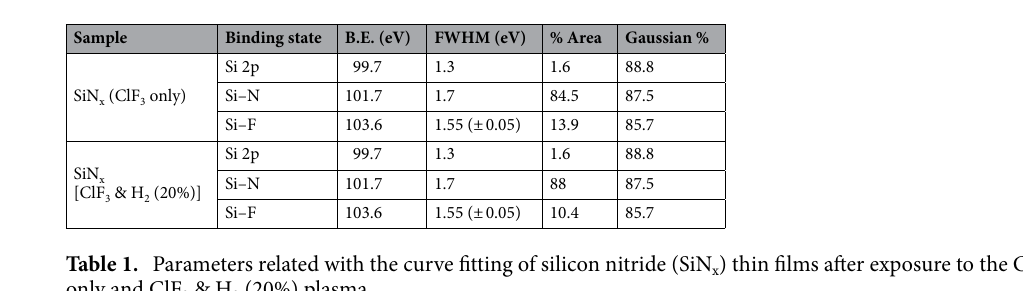
Figure 4. XPS narrow scan (Si 2p) data of SiN x ( a - c ), SiO y ( d - f ), and Cl 2p ( g , h ) after etching with a remote ClF 3 /H 2 plasma.